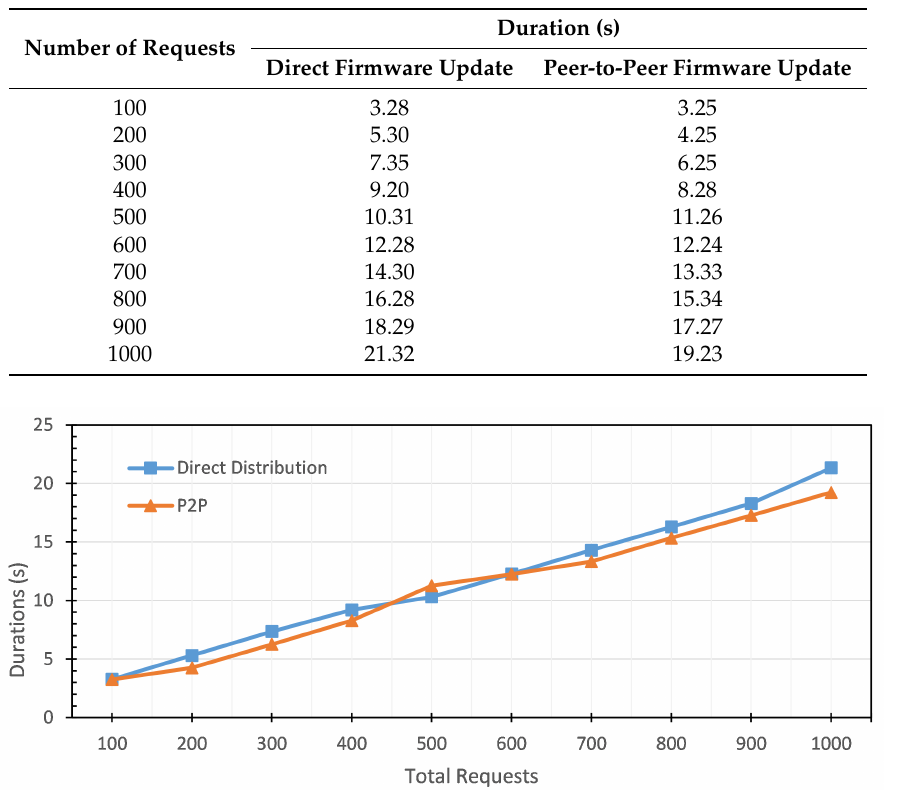
Figure 12. The duration of Download Update step: direct firmware update vs. peer-to-peer firmware update.